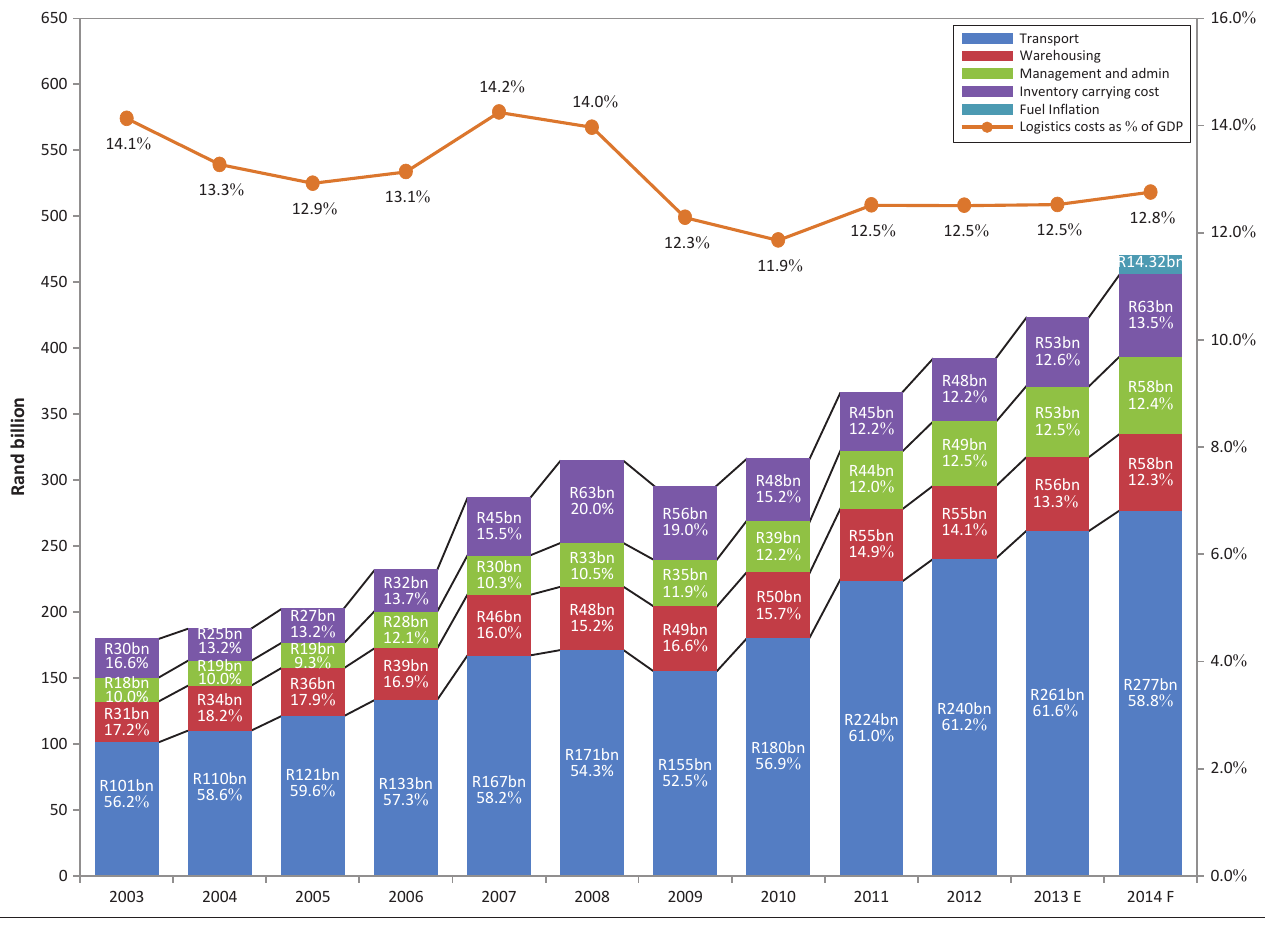
FIGURE 3: Total South African national logistics costs and the components,